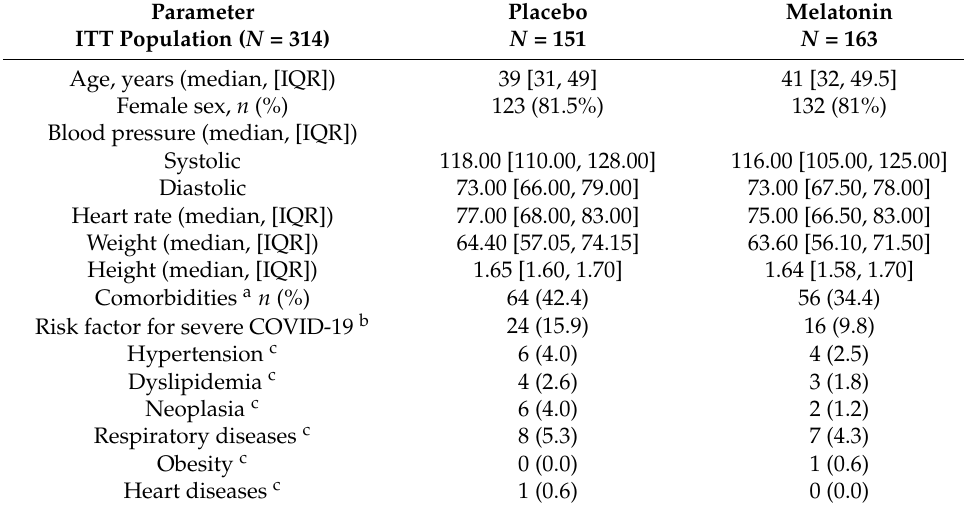
Table 1. Baseline